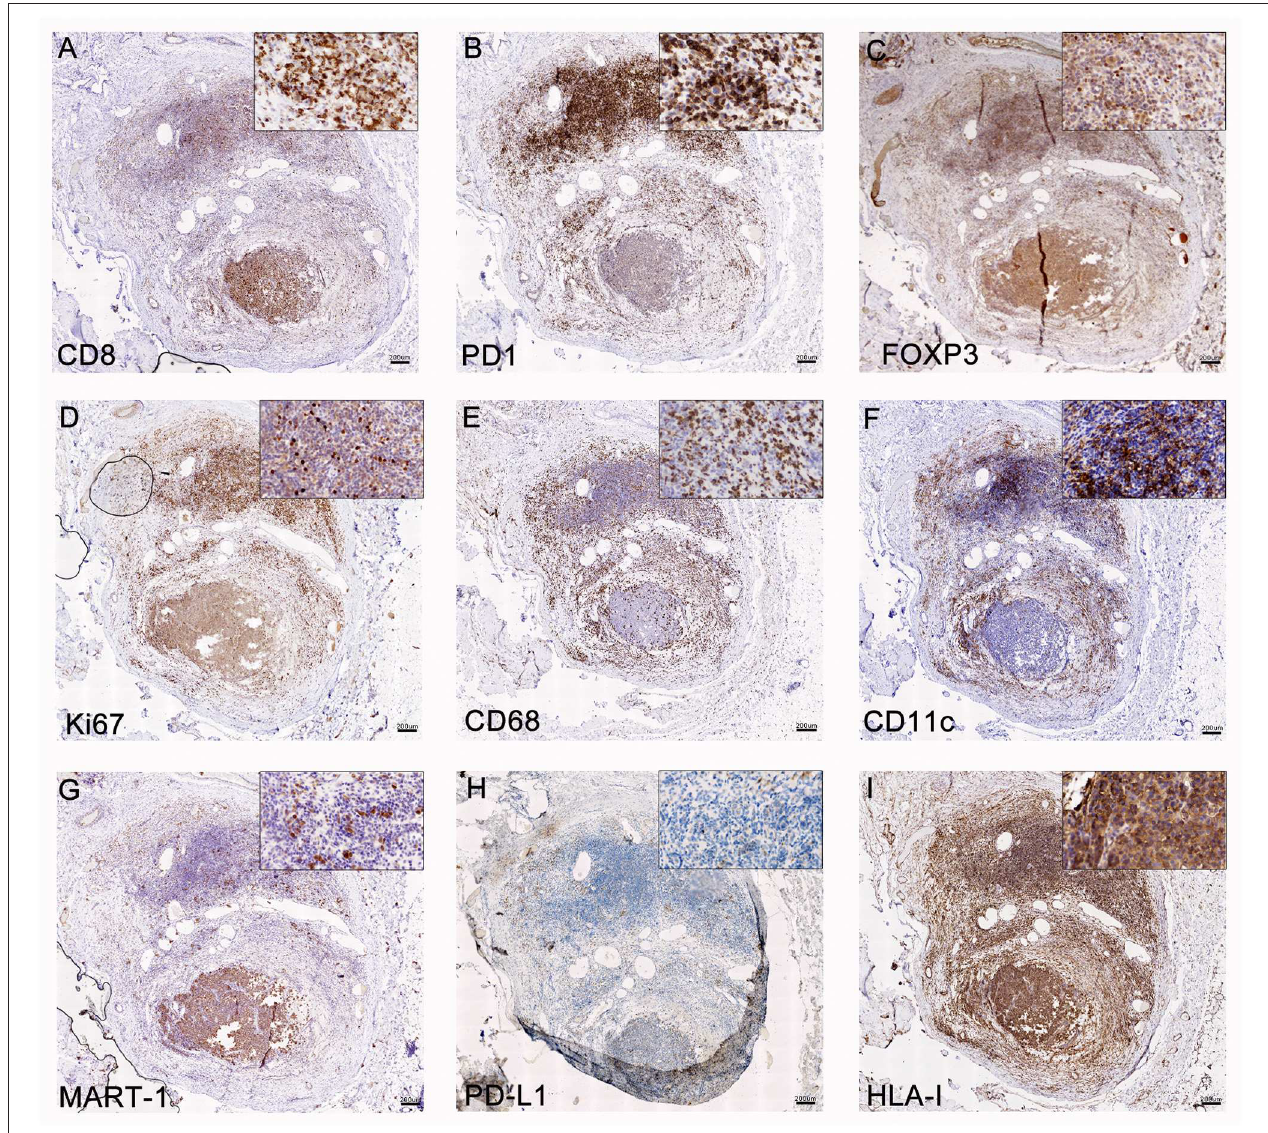
FIGURE 2 | Analysis of C-MTS tissue. In the area of tumor regression (upper part of the biopsy), CD8 + (A) and PD-1 + (B) T lymphocytes were mainly present, while FOXP3 + Treg were scarce (C) ; these lymphocytes were proliferating as determined by Ki-67 + staining (D) . Also, CD68 + macrophages (E) and CD11c Ag-presenting cells (F) were mainly concentrated in this area. In the lower part of the biopsy, MART-1 + (G) PD-L1 − (H) HLA class I + (I) viable tumor cells were observed. Original magnification = 20X. Scale bars = 200 µ m.